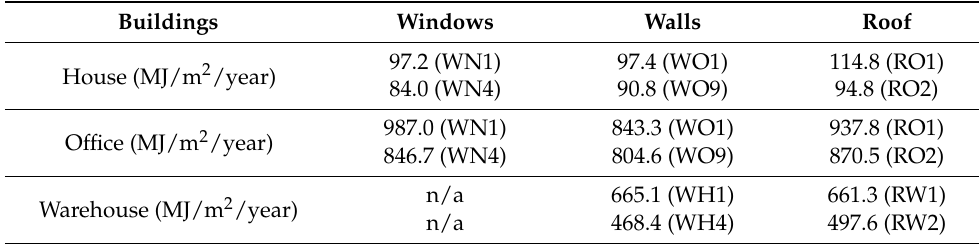
Table 9. Results of efficient materials and comparison with base model.